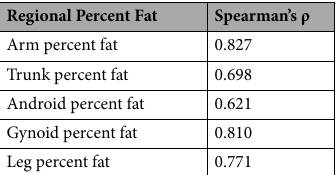
Table 3. Spearman correlations between BIA-assessed total percent body fat and DXA-assessed regional percent body fat. BIA bioimpedance, DXA dual X-ray absorptiometry. All p-values for correlation were < .0001.